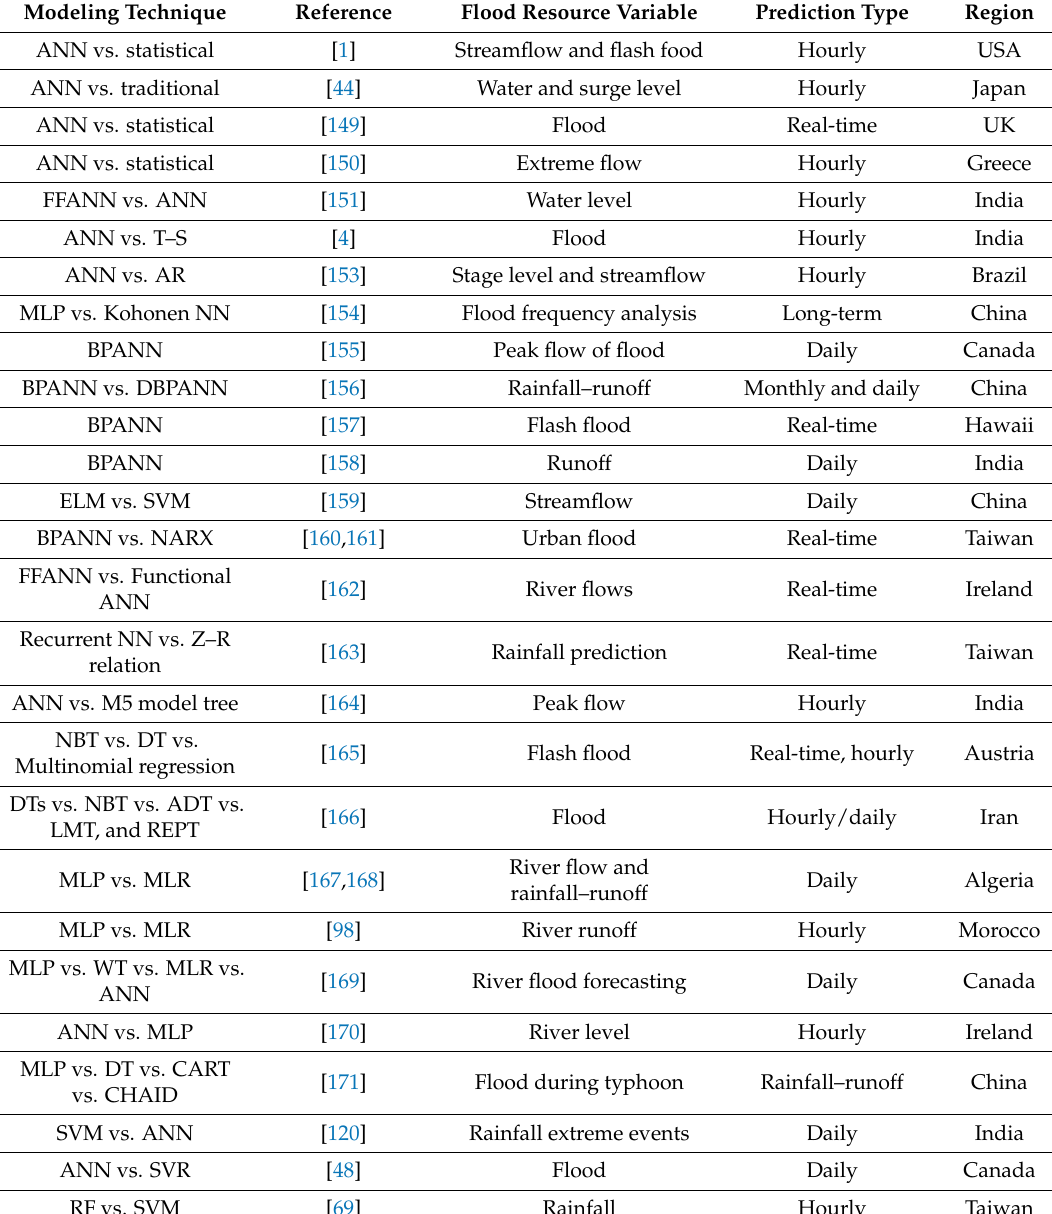
Table 1. Short-term predictions using single machine learning (ML)